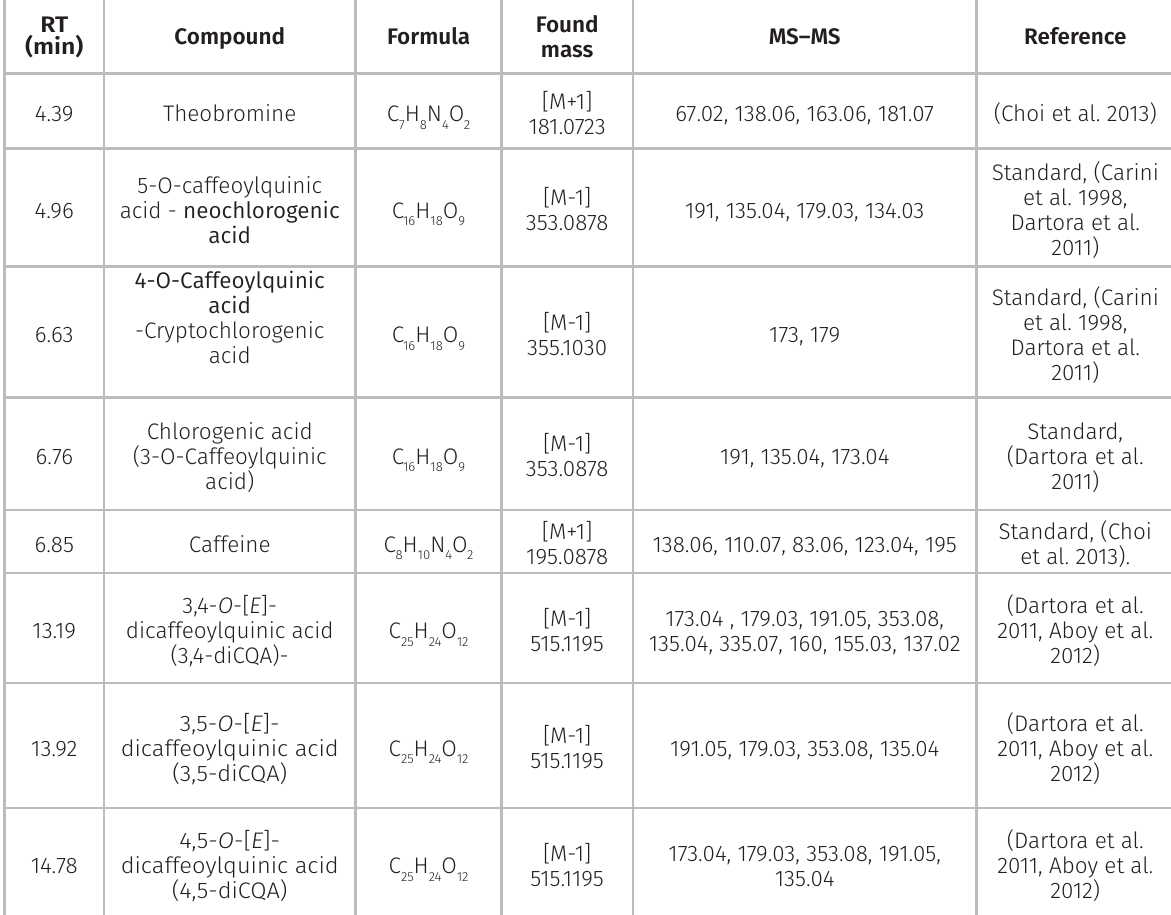
Table II. Ion MS fragmentation data of secondary compounds in I. paraguariensis callus. RT